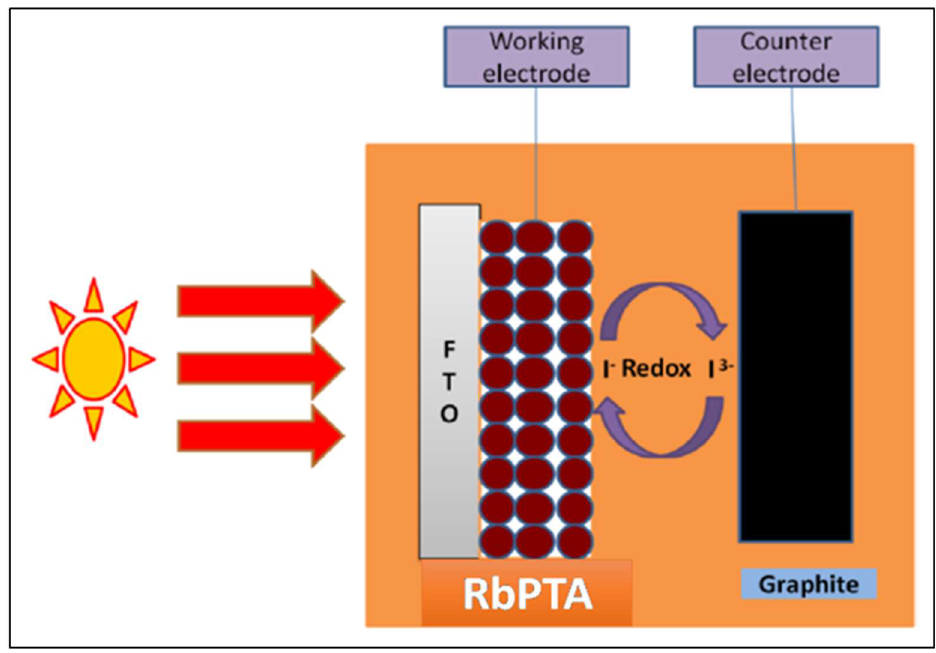
Figure 7. Schematic representation of Rb−PTA photocathode. The J-V characteristics of the Li − PTA, Rb − PTA, and In − PTA photocathodes were analyzed on the auto-lab electrochemical workstation shown in Figure 8a–c. When the photocathode was exposed to light, it absorbed incident light. As a result, an electronic transition appeared from the valence band (VB) to the conduction band (CB). Current density–voltage measurements were performed on deposited Li − PTA, Rb − PTA, and In − PTA samples without and with illumination from a 100 mW/cm 2 filament lamp. Figure 8 shows that, under dark conditions, Li − PTA, Rb − PTA, and In − PTA photoelectrodes behave similarly to rectifier diodes, and under light irradiation, it is observed that the magnitude of the open-circuit voltage increases with positive polarity, confirming that Li − PTA, Rb − PTA, and In − PTA photoelectrodes are p -type semiconductors.